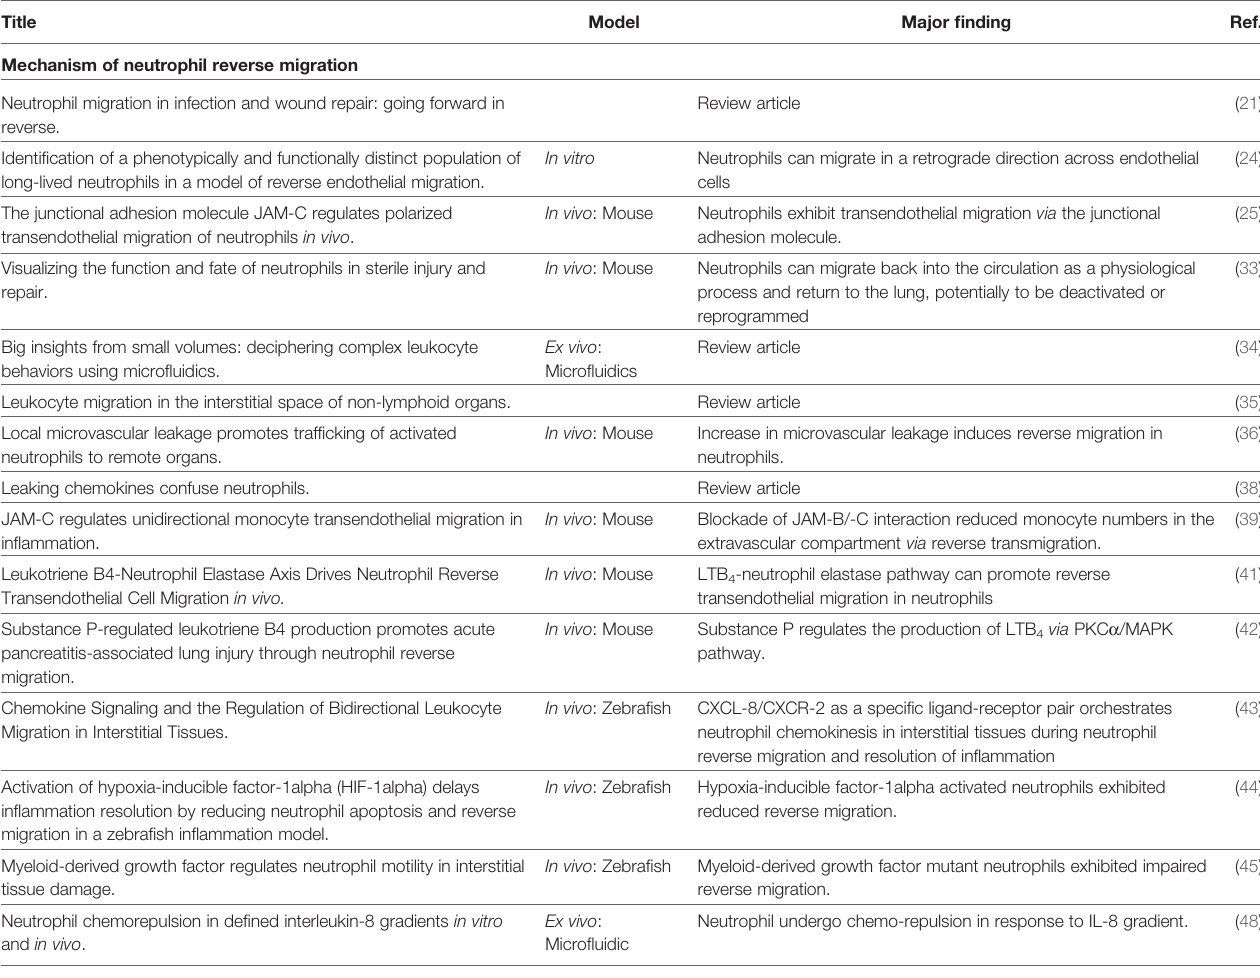
TABLE 2 | Summary of studies on the mechanism of reverse migration in neutrophils.